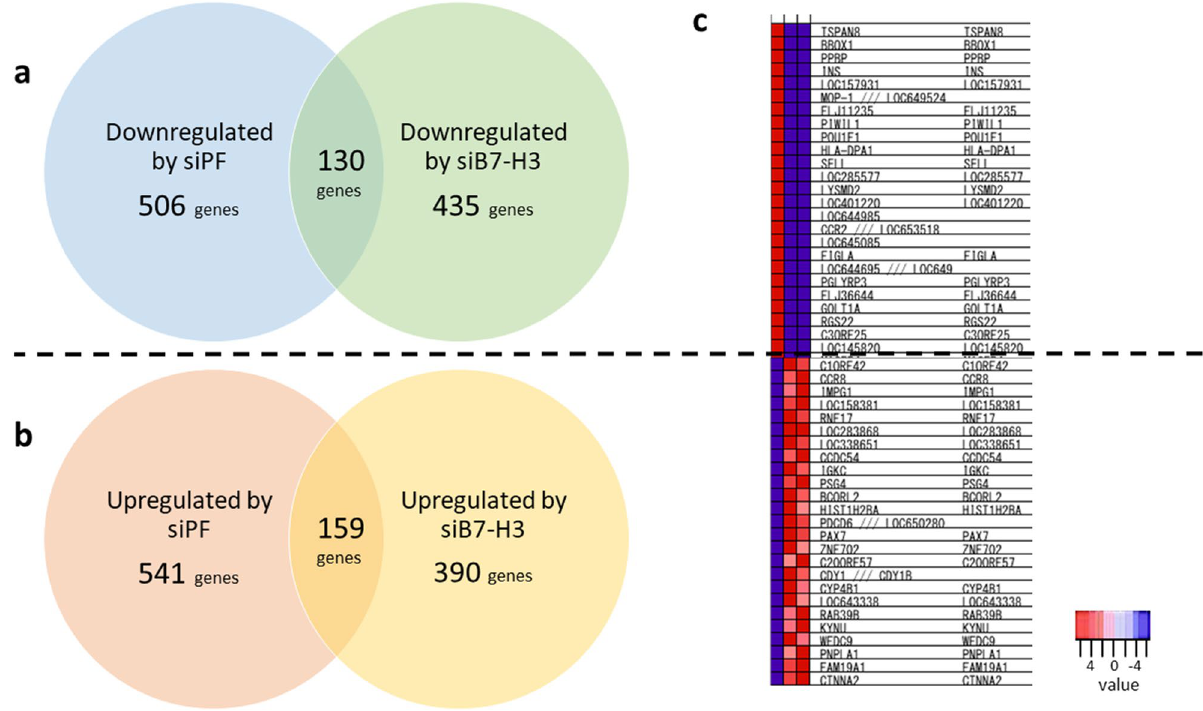
Figure 2. Gene expression analysis. Knockdown of PAX3-FOXO1 and B7-H3 reveal shared down/upregulated genes. ( a ) Venn diagram of genes that were downregulated by the knockdown of PAX3-FOXO1 or B7-H3 . ( b ) Venn diagram of genes that were upregulated by the knockdown of PAX3-FOXO1 or B7-H3 . ( c ) Heat map of the top 50 genes that were down/up-regulated by the knockdown of PAX3-FOXO1 or B7-H3 . The left line shows Rh-30 siCont, the middle Rh-30 siPF, and the right (Fig. 1c,d). These results suggest that PAX3-FOXO1 positively regulates the expression of B7-H3 at both the mRNA and protein levels. PAX3‑FOXO1 and B7‑H3 are associated with multiple pathways related to an aggressive rhab‑ domyosarcoma phenotype. To unravel the pathways affected by PAX3-FOXO1 and B7-H3 in ARMS, gene expression analysis was performed using microarray and gene set enrichment analysis (GSEA). The gene expression signature of siPF or siRNA targeting B7-H3 (siB7-H3) transfected Rh-30 cells (Rh-30 siPF or Rh-30 siB7-H3, respectively) was compared with that of control siRNA (siCont) transfected Rh-30 cells (Rh-30 siCont). Gene expression analysis revealed that in Rh-30 siPF and Rh-30 siB7-H3, the expression levels of 636 and 565 genes were decreased, respectively (log 2 ratio, ≤ 1.0), and those of 700 and 549 genes were increased, respectively (log 2 ratio, ≥ 1.0), compared with the respective levels in Rh-30 siCont (Fig. 2a,b). Among them, the expression levels of 130 genes were downregulated and those of 159 genes were upregulated in both the Rh-30 siPF and Rh-30 siB7-H3 compared to the respective levels in the Rh-30 siCont (Fig. 2a,b). A heat map of top 50 shared downregulated or upregulated genes is shown in Fig. 2c. GSEA revealed that several pathways related to chemotaxis, INF-γ production, and regulation of T cell immunity were inactivated in both Rh-30 siPF and Rh-30 siB7-H3 unlike in Rh30 siCont, suggesting that PAX3- FOXO1 and B7-H3 may contribute to tumor cell metastasis and immune evasion (Fig. 3a,b). In contrast, several pathways related to muscle cell differentiation were activated in both Rh-30 siPF and Rh-30 siB7-H3 but not in Rh30 siCont, suggesting that PAX3-FOXO1 and B7-H3 may block myoblast differentiation (Fig. 3c,d). PAX3‑FOXO1 and B7‑H3 are associated with cell migration. To confirm that PAX3-FOXO1 and B7- H3 contribute to metastasis in ARMS, as suggested by GSEA, we performed wound healing and transwell assays. Wound healing assays revealed that cell migration in ARMS was significantly attenuated by the knockdown of PAX3-FOXO1 or B7-H3 in all the three cell lines (Fig. 4a,b). The transwell assays similarly demonstrated that cell migration in ARMS was significantly attenuated by the knockdown of PAX3-FOXO1 or B7-H3 in all the three cell lines (Fig. 4c). To determine the pathways contributing to cell migration that are affected by PAX3-FOXO1 and B7-H3 , we performed qRT-PCR for CXCR4 and STYK1 , as gene expression analysis indicated that both these genes were downregulated in Rh-30 siPF and Rh-30 siB7-H3. As expected, CXCR4 was downregulated by transfection of all the three cell lines with siPF or siB7-H3 (Fig. 5a). In addition, STYK1 was downregulated in Rh-30 and Rh-41 by transfection with siPF or siB7-H3, although in Rh28, STYK1 was downregulated by transfection with siPAX3-FOXO1, but not siB7-H3 (Fig. 5b).